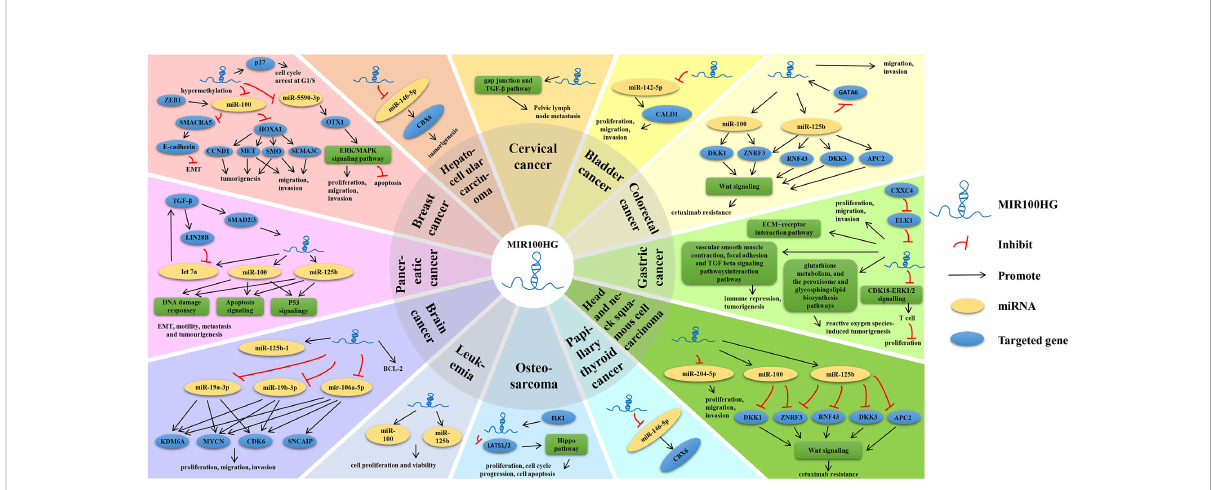
FIGURE 5 Multiple known regulatory mechanisms of MIR100HG in various human